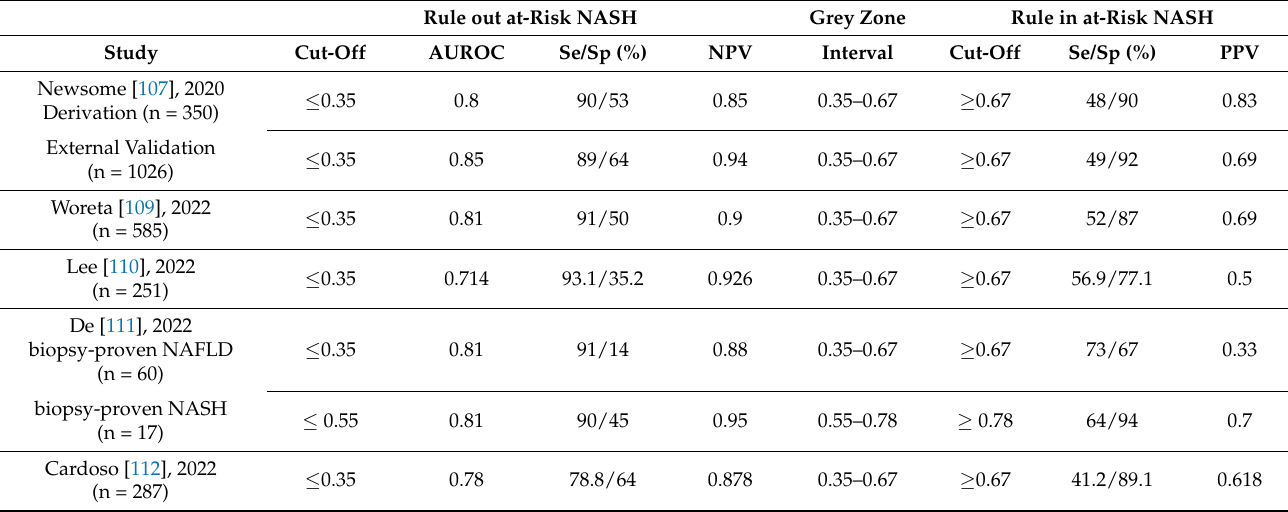
Table 4. Performance of FAST core cut-off values for detecting at-risk NASH (NASH + NAS ≥ 4 + F ≥ 2) in biopsy-proven